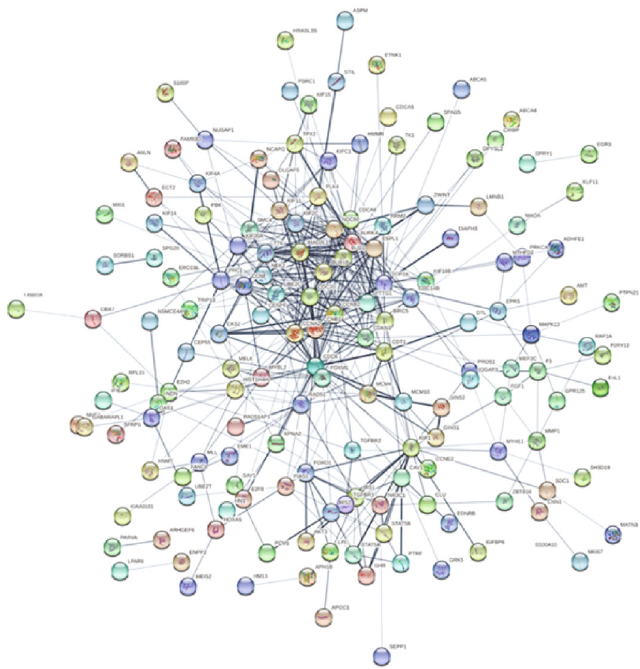
Figure 1: GO function analysis and KEGG pathway analysis of di ff erentially expressed genes associated with overall survival. KEGG pathway analysis revealed these bases because of participating in cell cycle, human T cell leukemia virus 1